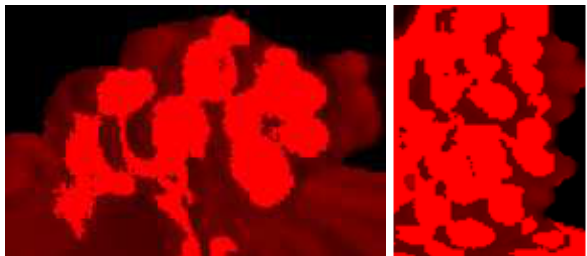
Figure 8: Results of a standard region growing at the two regions of interest in the intensity images.